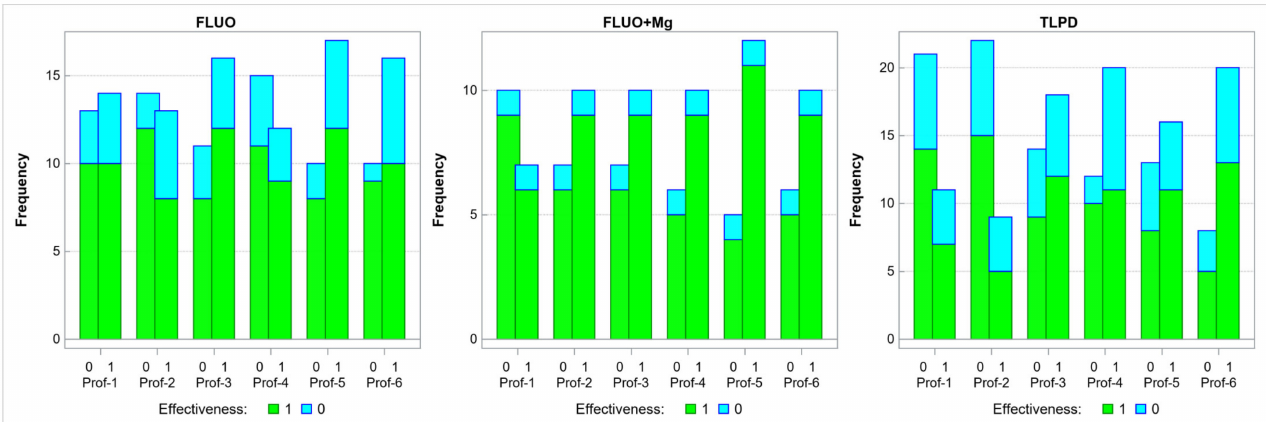
Figure 5. The number of patients who achieved (1) and failed to achieve (0) a positive pharmaco-EEG profile at the individual time points in three treatment groups, with green areas indicating a 50% improvement in the HDRS scores at week 8. FLUO— fluoxetine; Mg—magnesium; TLPD—tricyclic antidepressant; Prof—pharmaco-EEG profile; and Effectiveness—adequate treatment